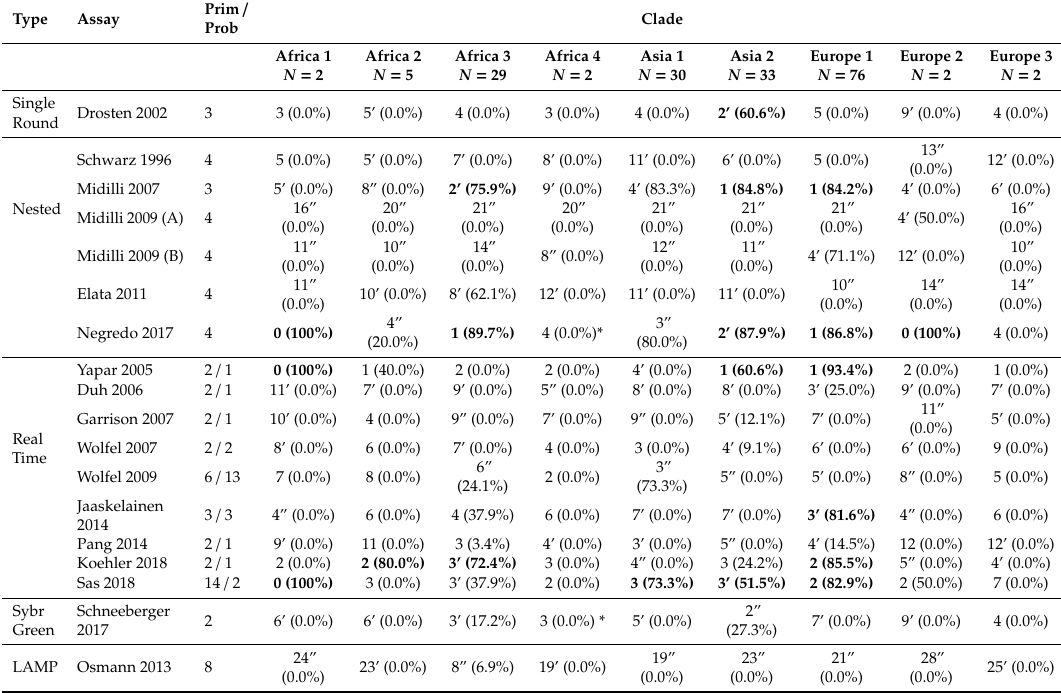
Table 2. Scoring summary of the molecular assays. For each clade the number of mismatches between the best primer / probe set and the most divergent sequence is reported. The apostrophes indicate the presence of one or more critical mismatches. The percentage of sequences with no mismatches are shown are shown in brackets. The best results (i.e., over all threshold parameters—see Methods) are shown in